Question: Briefly state, in one sentence, what is plotted here.
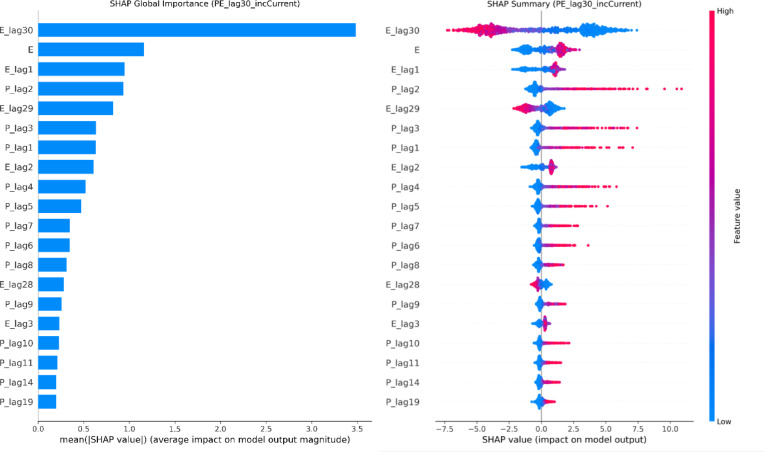
Answer: Global interpretability of the standalone XGBoost model based on meteorological inputs using SHAP analysis. The left panel presents the feature importance ranked by the mean absolute SHAP values, while the right panel shows the SHAP beeswarm plot illustrating the distribution and direction of feature impacts on streamflow predictions. The results indicate that the model predominantly relies on lagged precipitation (P) and reference evapotranspiration (E), reflecting a purely data-driven learning behavior in the absence of conceptual hydrological states.